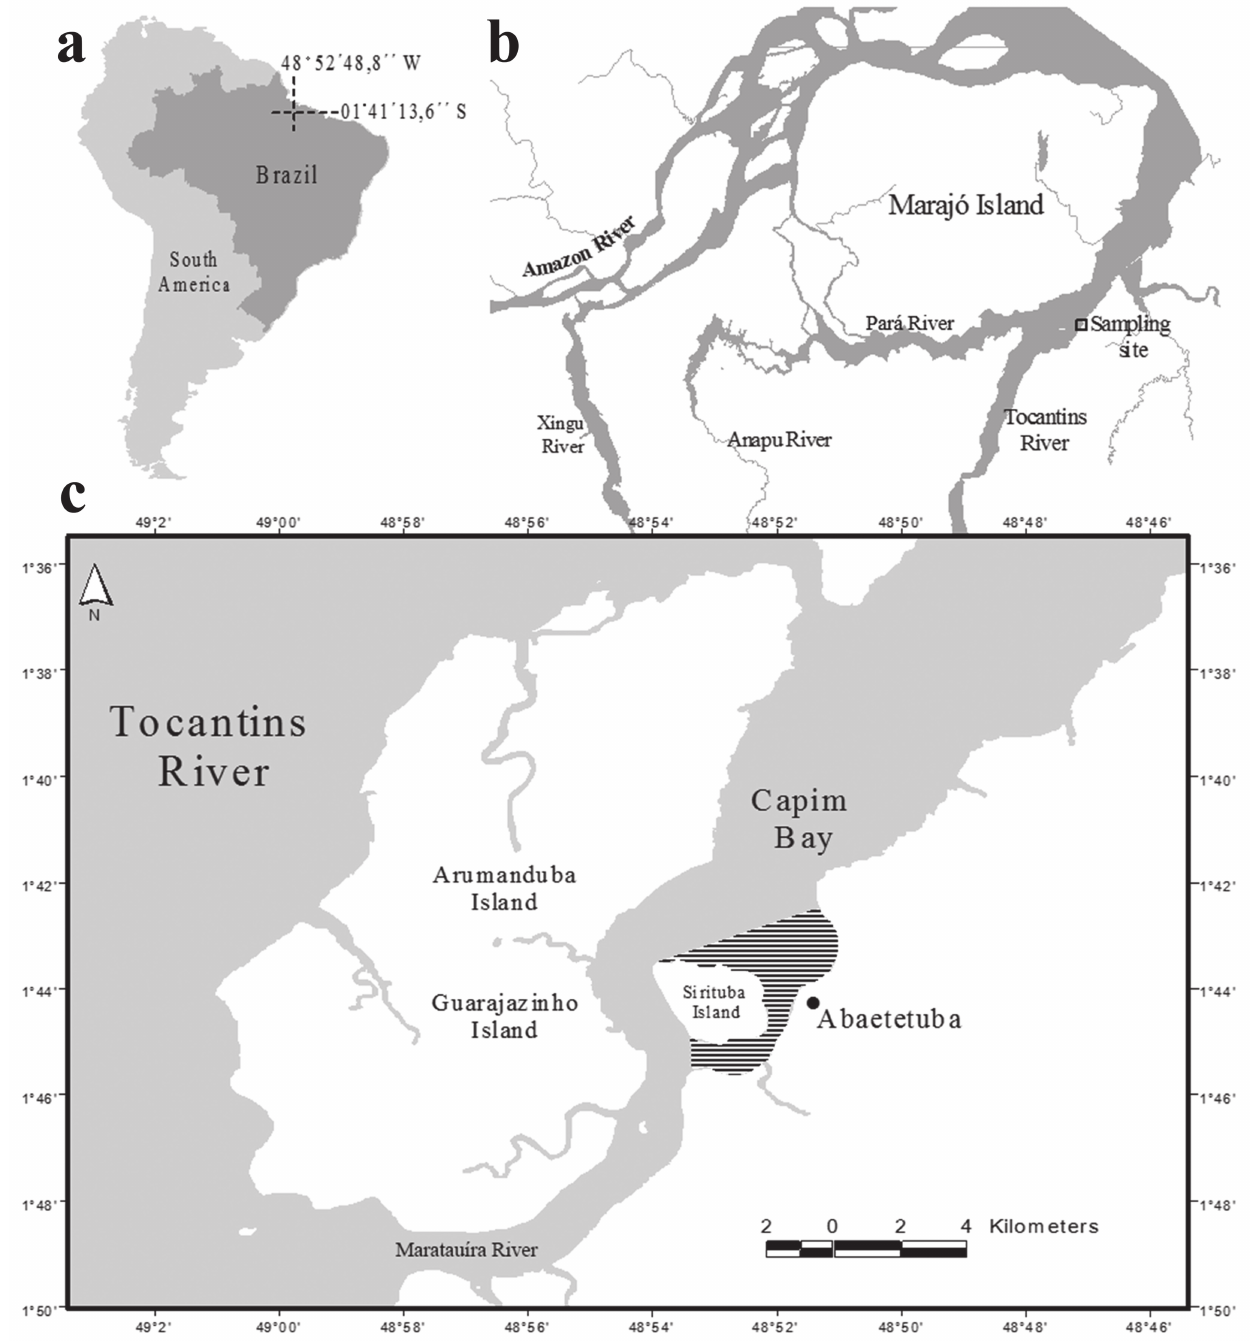
Fig. 1. Location of the study area near the mouth of the Amazon River in Brazil. a. Location of Brazil in South America; b. Amazon River mouth with the sampling site; c. Study area (specimens were collected within the shaded